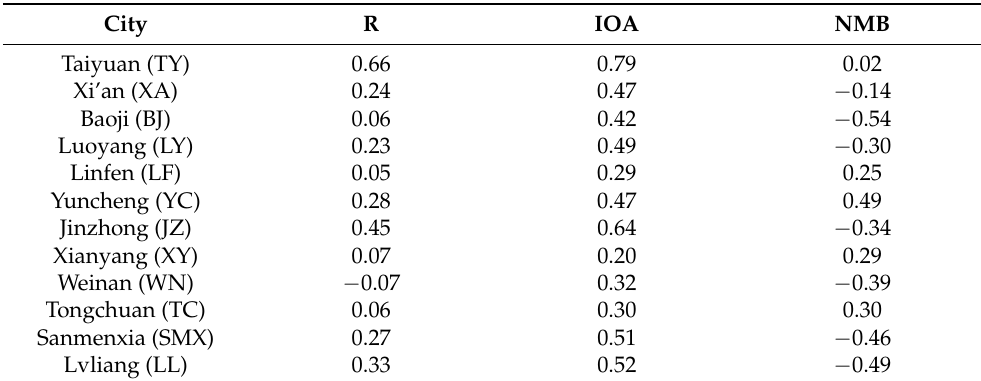
Figure 5. The observed and predicted concentrations of PM 2.5 . Table 6. Assessment parameters for PM 2.5